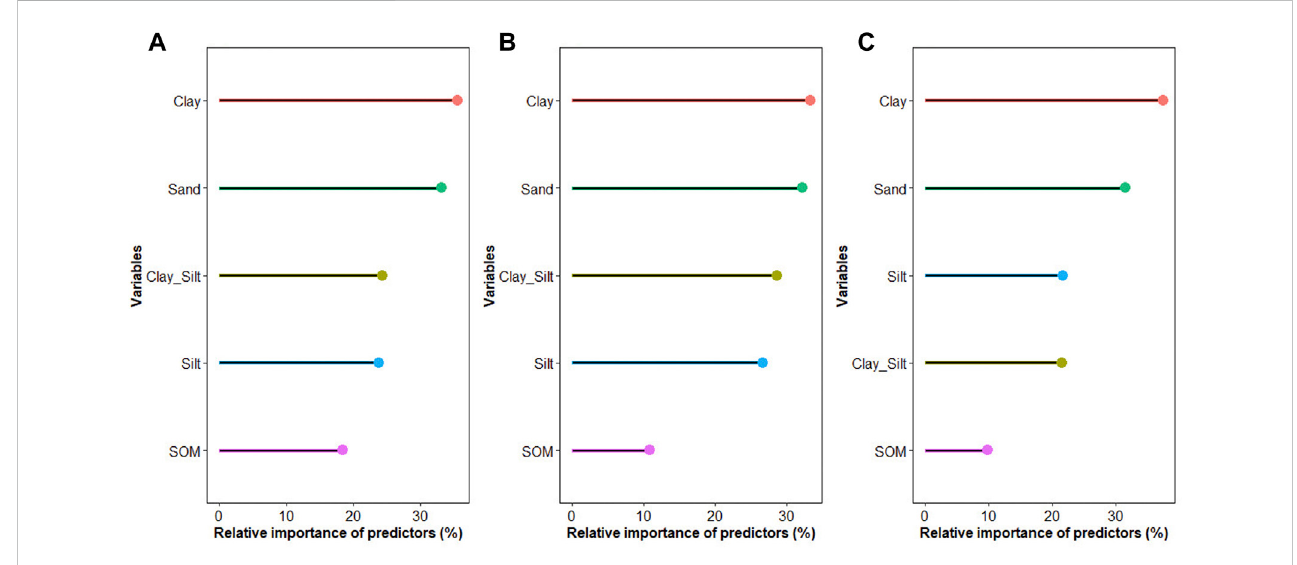
FIGURE 6 Variable importance of the predictor used in random forest models to predict soil water content: (A) at saturation ( w 0 ) , (B) at fi eld capacity point ( w 330 ), and (C) at permanent wilting point ( w 15000 ) using the following variables: Clay, Sand, Clay_Silt (clay content + silt content), silt and soil organic matter (SOM).